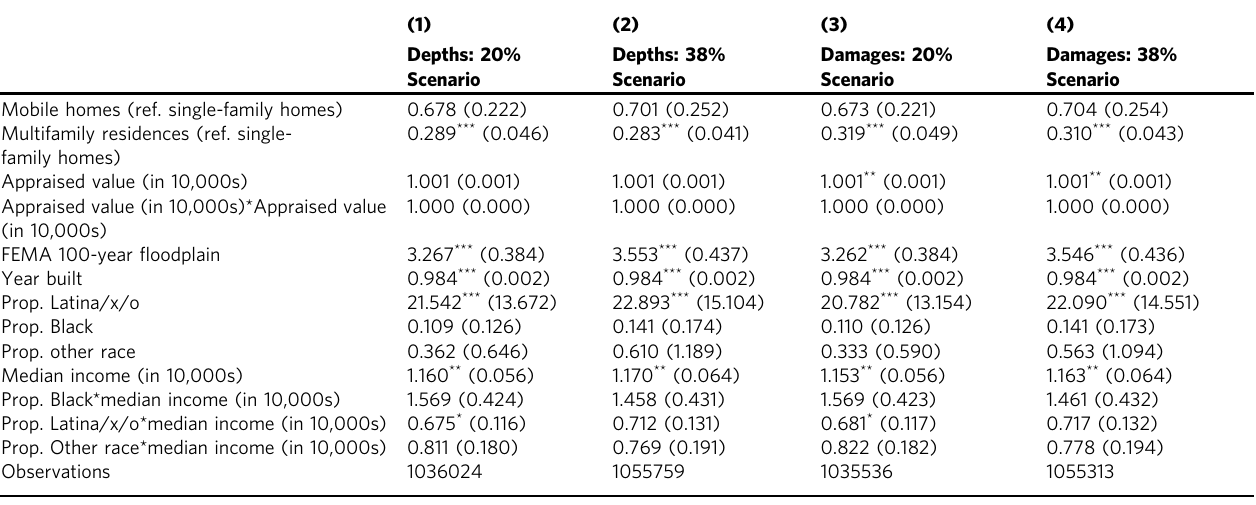
Table 2 Logistic regression of climate change-attributed depths for Hurricane Harvey in Harris County,